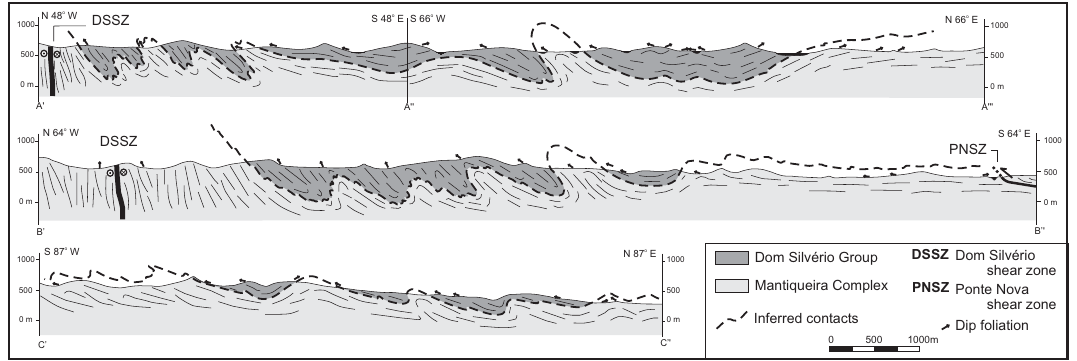
Fig. 6 – Simplified cross-sections of the Guaraciaba Synclinorium. The location of the section is indicted in Figure 4. The S 1 foliation pervasively affects all previ- ously described units. In the gneisses of the Man- tiqueira Complex and in the Dom Silvério metased- iments, S 1 parallels the gneissic banding and the compositional layering. In the Borrachudos